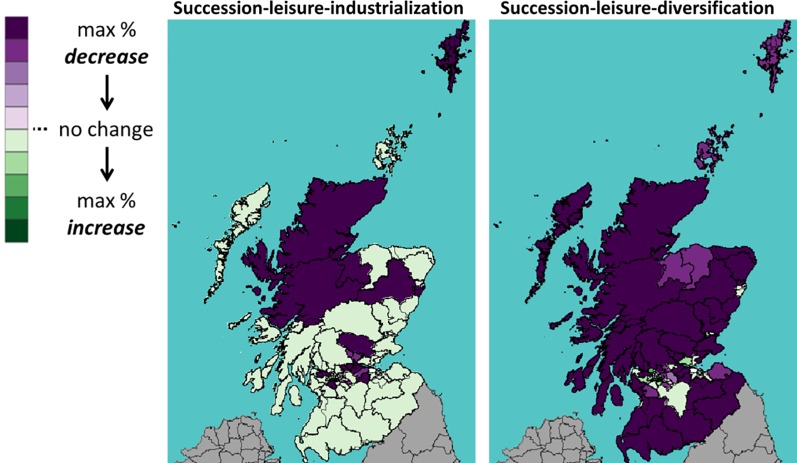
Percentage change in the number of all cattle under WTO scenario.